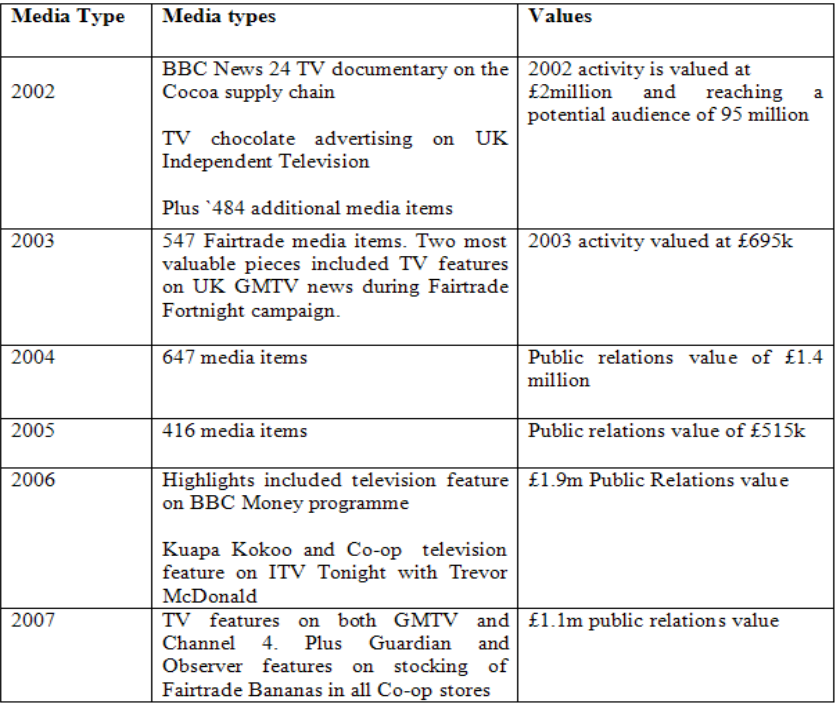
Table 2: Co-operative Food Fairtrade Media